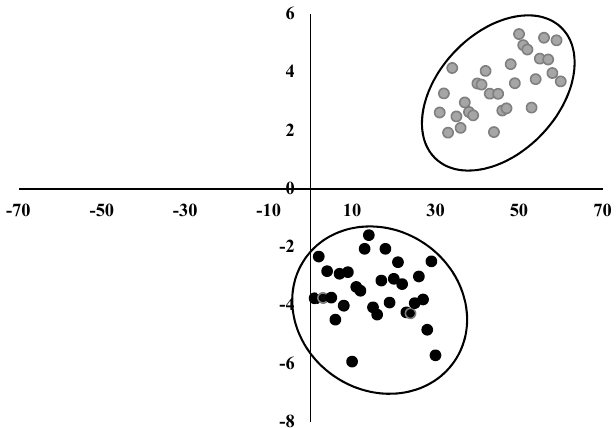
Table 3. Discriminant analysis using the whole dataset of sweet cherry Early Bigi grafted on SL 64 and Maxma 60 rootstocks. Parameters included in the function: larger diameter (LD), soluble solids